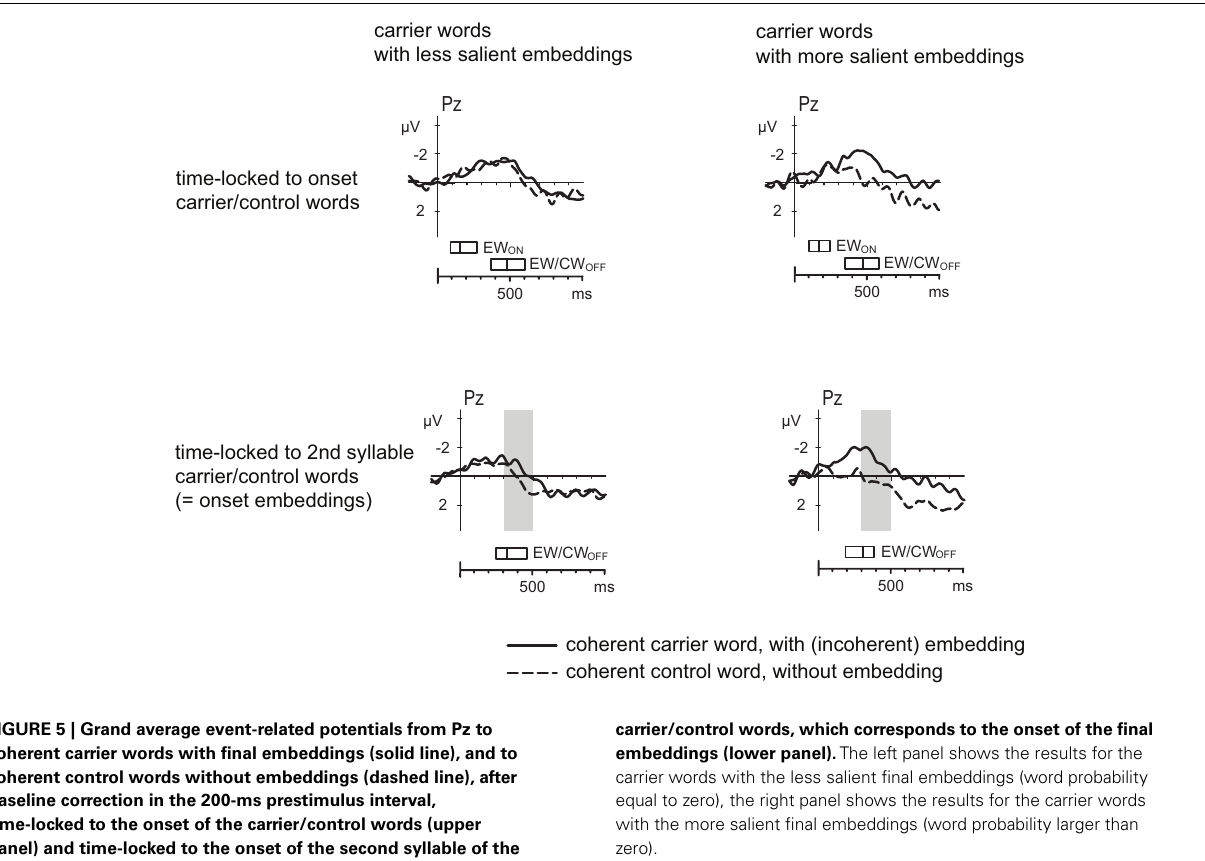
carrier/control words, which corresponds to the onset of the final embeddings (lower panel). The left panel shows the results for the carrier words with the less salient final embeddings (word probability equal to zero), the right panel shows the results for the carrier words with the more salient final embeddings (word probability larger than